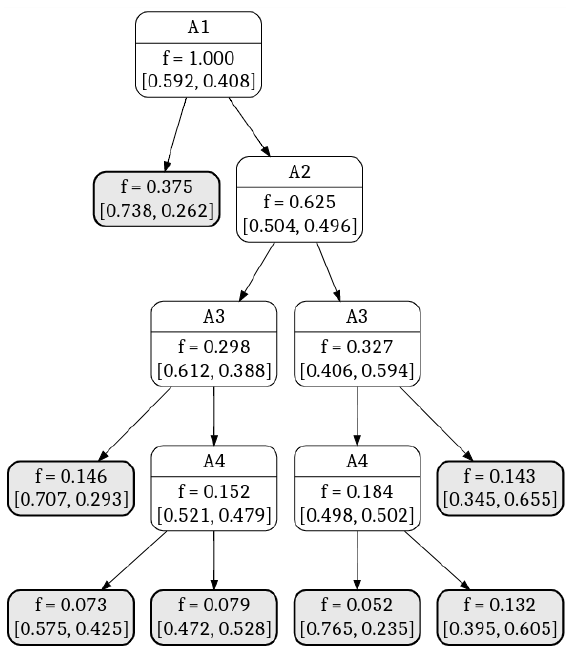
Figure 3. Fuzzy Decision Tree (FDT) of the simplified laparoscopic surgery procedure inducted based on data in Table 2 ( = 0.15 and = 0.70). Table 4. Structure function of the simplified laparoscopic surgery procedure.